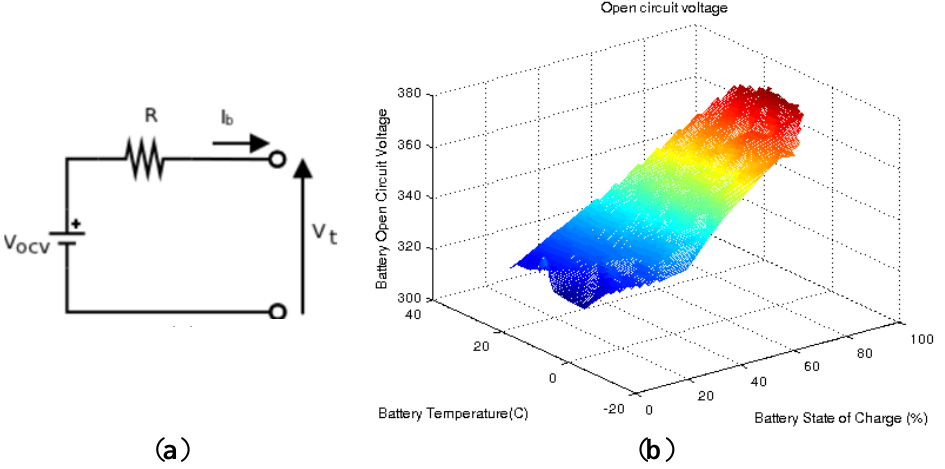
Figure 2. ( a ) Rint model for a single Li-ion cell; and ( b ) efficiency